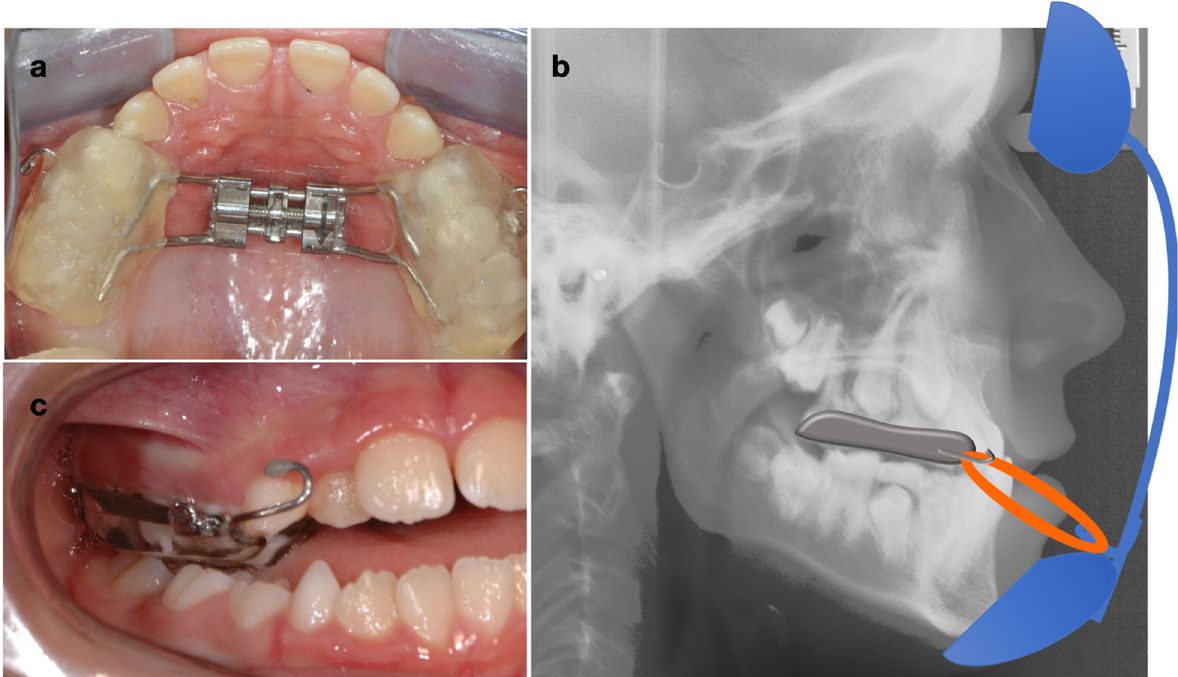
Fig. 3 A Bonded Hyrax appliance with acrylic bite blocks; B Face mask hooks emerge near the maxillary canine for elastic application; C Face mask elastic force vector at approximately 30° down from the occlusal